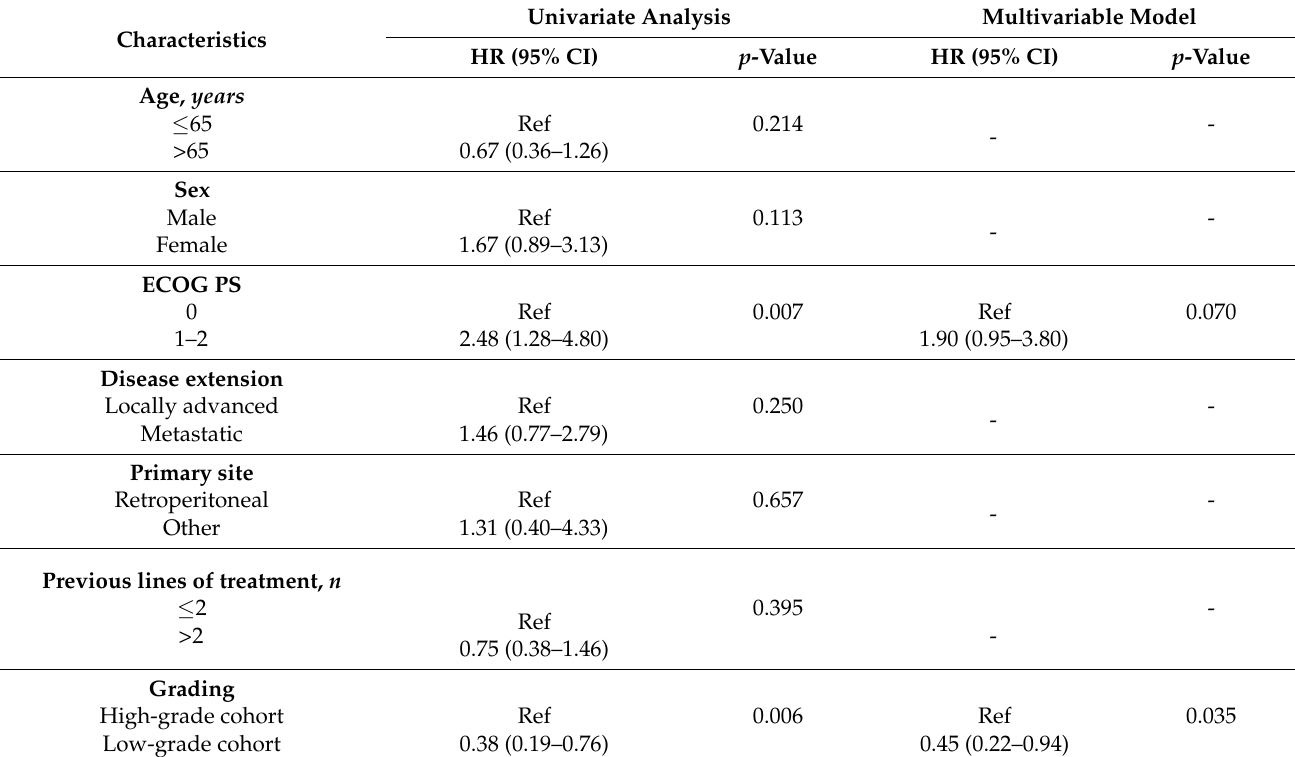
Figure 1. Kaplan–Meier curves for progression-free survival (PFS) ( A ) and OS ( B ) according to pathological stratification. Dark green lines indicate patients in the low-grade cohort whereas orange lines indicate patients in the high-grade cohort. Table 4. Cox proportional-hazards regression models for